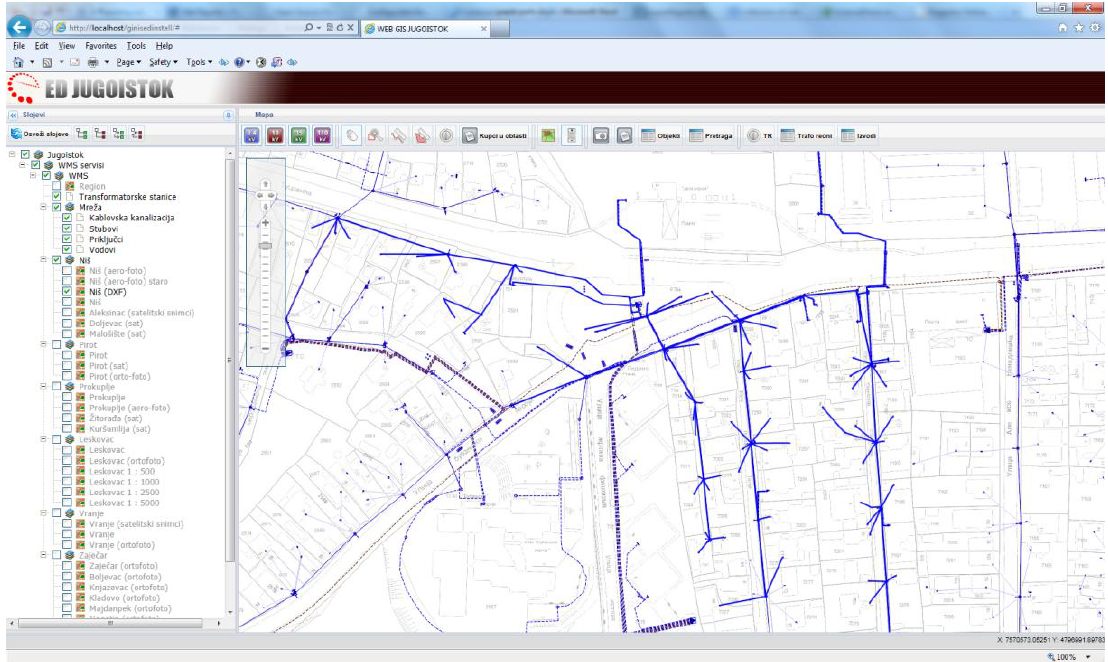
Figure 8. A part of the electric power supply network in the city of Niš which was under observation during the simulation process.